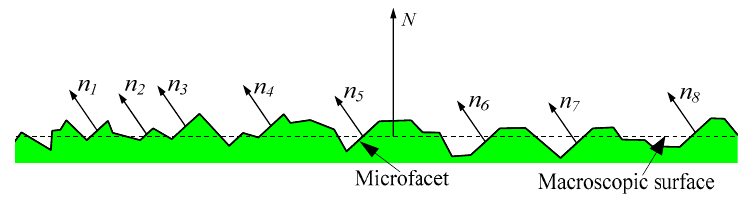
Figure 3. Distribution of the normal declination angle of the microfacet.